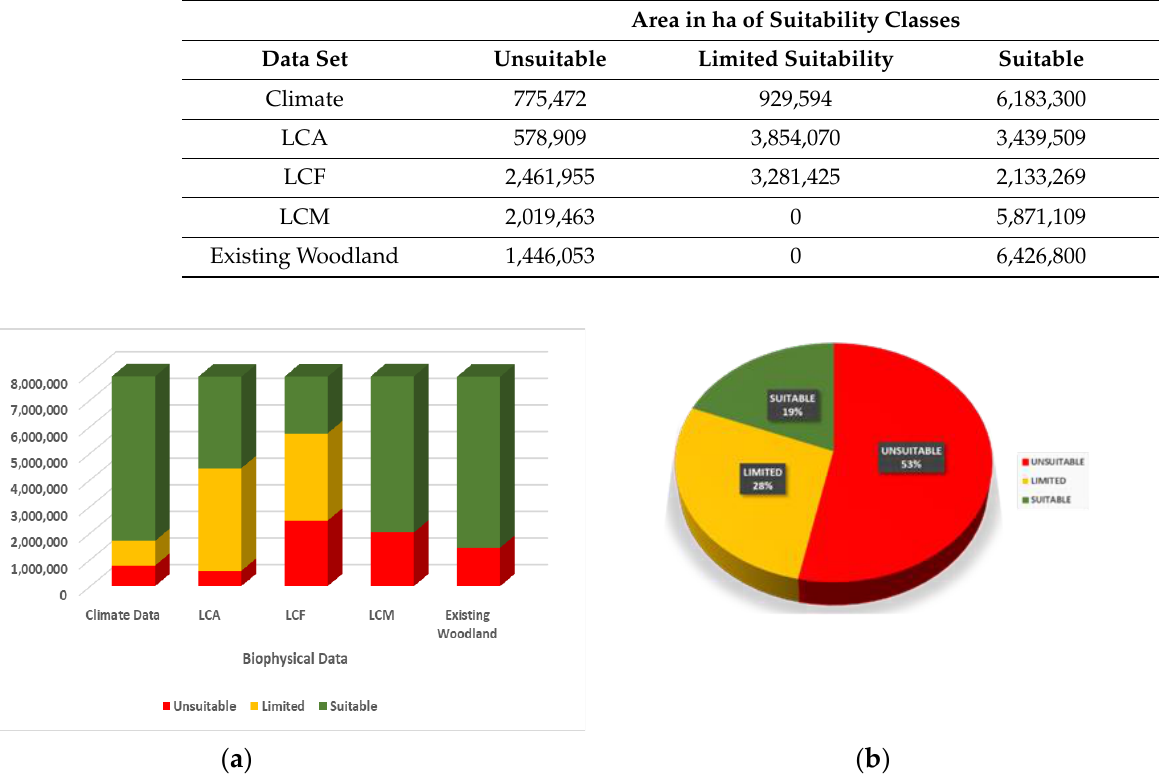
Table 6. Unsuitable/limited/suitable land areas based on each biophysical dataset.